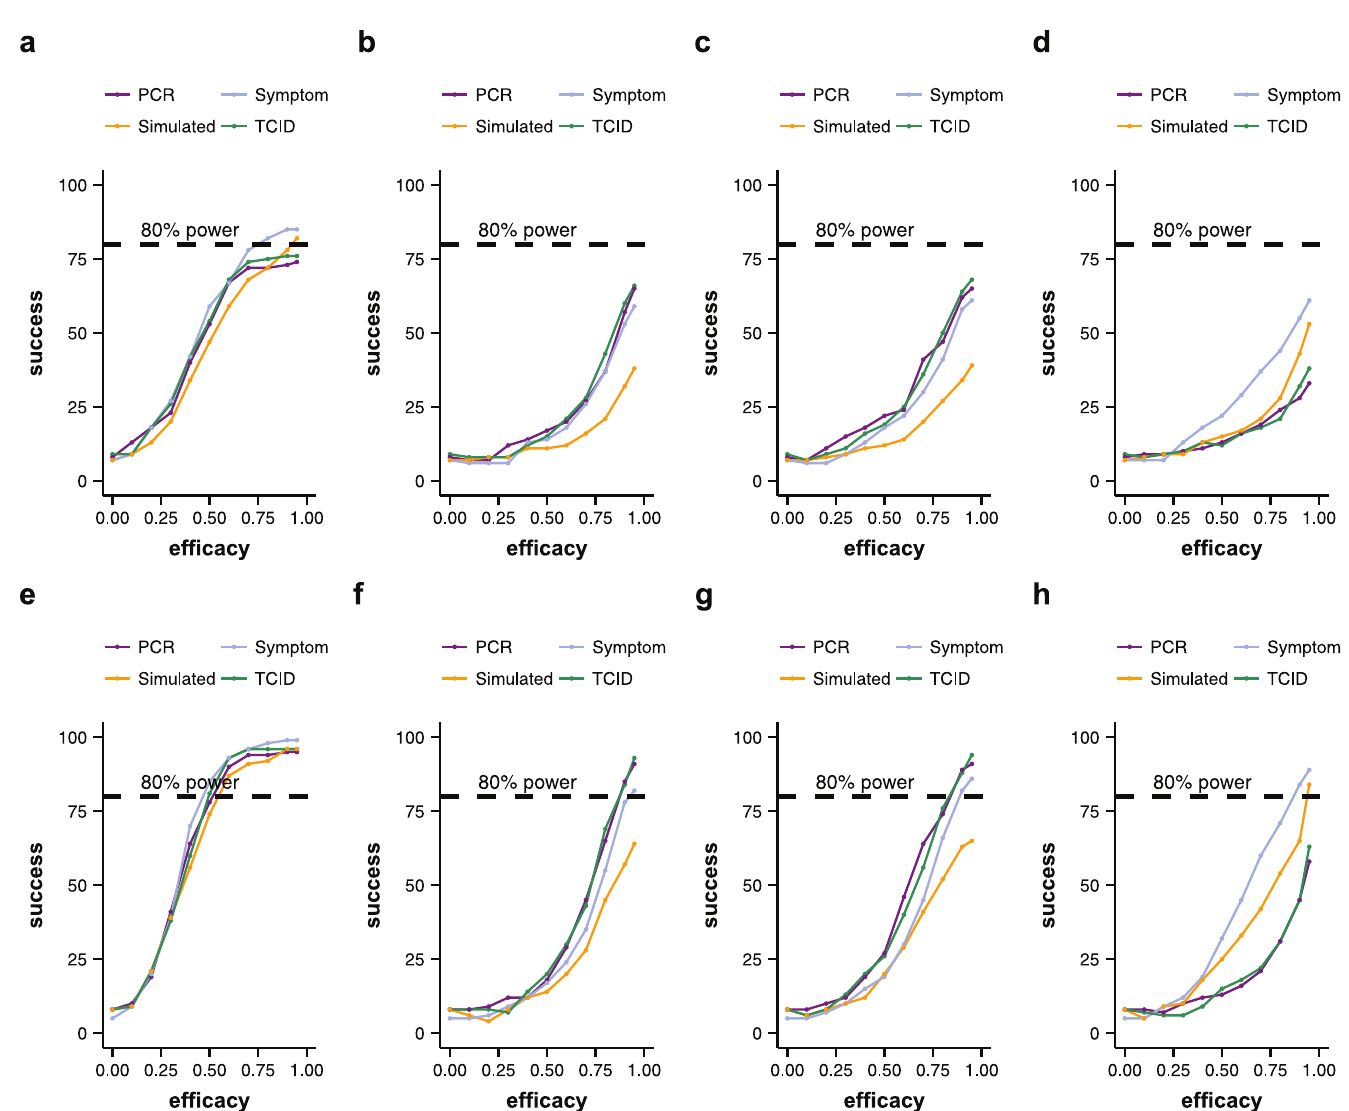
Fig 3. Experiment 1: Individual variability in natural infection. The plots show the number of successful trials out of 100 simulated trial runs (y-axis) for different assumed efficacies of the treatment (x-axis). All 100 iterations for each assumed efficacy value had exactly the same setup and differed only in the random number seed. The number of successful trials out of 100 runs can be interpreted as the power of the trial. The power of the trial depends on the mechanism of action of the treatment and the number of patients in the trial. As individual variability in natural infection is large, trials with 50 patients do not reach a power of 80%, even if the assumed efficacy of the treatment is high (90+%). Coloured lines show the number of successful trials out of 100 runs depending on efficacy for different endpoint measurements (PCR: viral load AUC measured with qPCR; Symptom: temperature AUC; TCID: viral load AUC measured with TCID 50 ; Simulated: viral load AUC of the simulated viral load AUC). Upper row: trials with 50 patients. Lower row: trials with 100 patients. a, e: treatment acts on all stages of the virus life cycle/model parameters. b, f: treatment acts on the infection rate. c, g: treatment acts on the virus production rate. d, h: treatment acts on the virus clearance